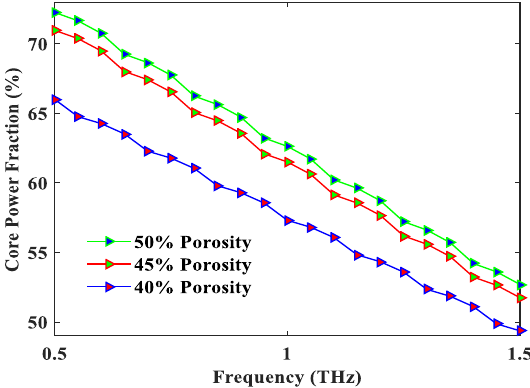
Figure 6. The core power fraction as a function of frequency for different porosities.